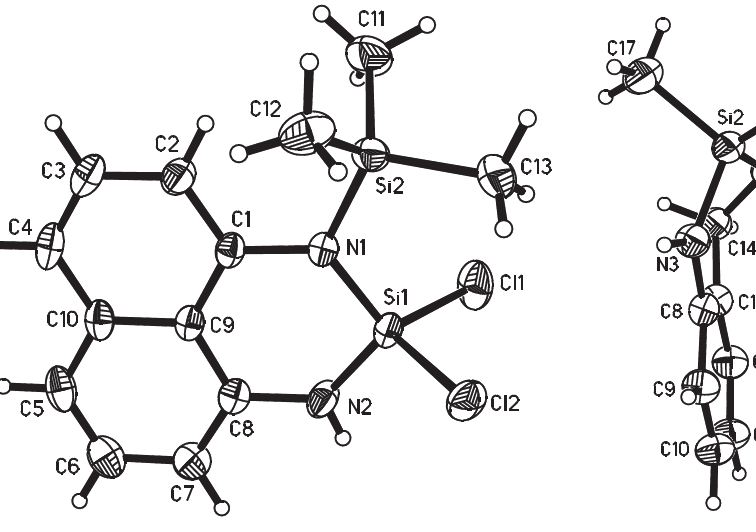
Figure 9: Molecular structure of 5d-TMS including numbering scheme. The thermal displacement ellipsoids of the non-hydrogen atoms are drawn at the 50% probability level. The methyl groups at C11 and C12 are rotationally disordered. Their alternative positions C11A and C12A have been omitted for clarity.